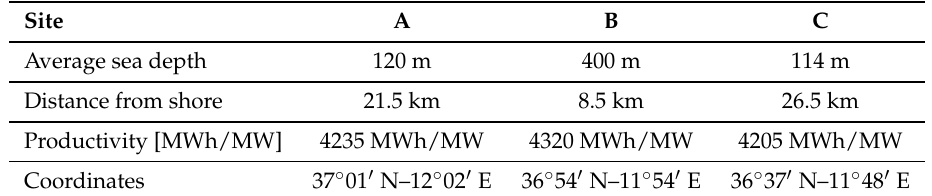
Table 5. Sites characteristics.